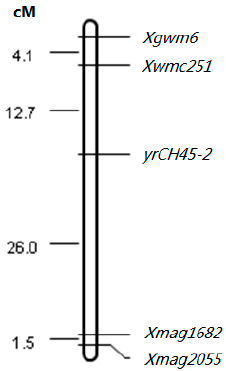
Figure 4. Map position of yrCH45-2 on chromosome 4BL. Heterozygous F 2 translocation lines (1RS.1BL) were used to map the resistance locus on 4BL as resistance on the translocation was recessive and would, therefore, not confound phenotypic responses associated with segregation on 4BL.